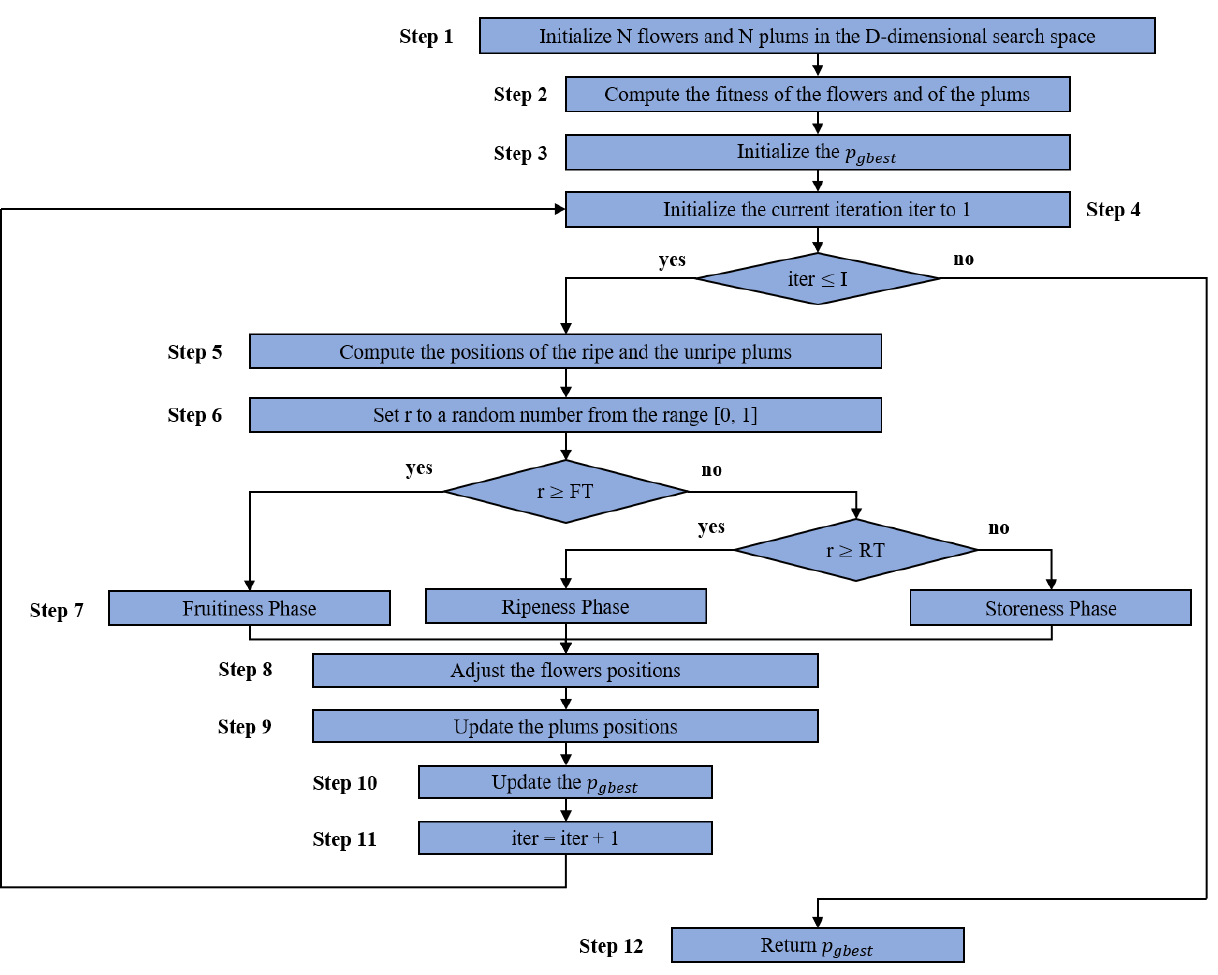
Figure 3. PTA High-Level View.